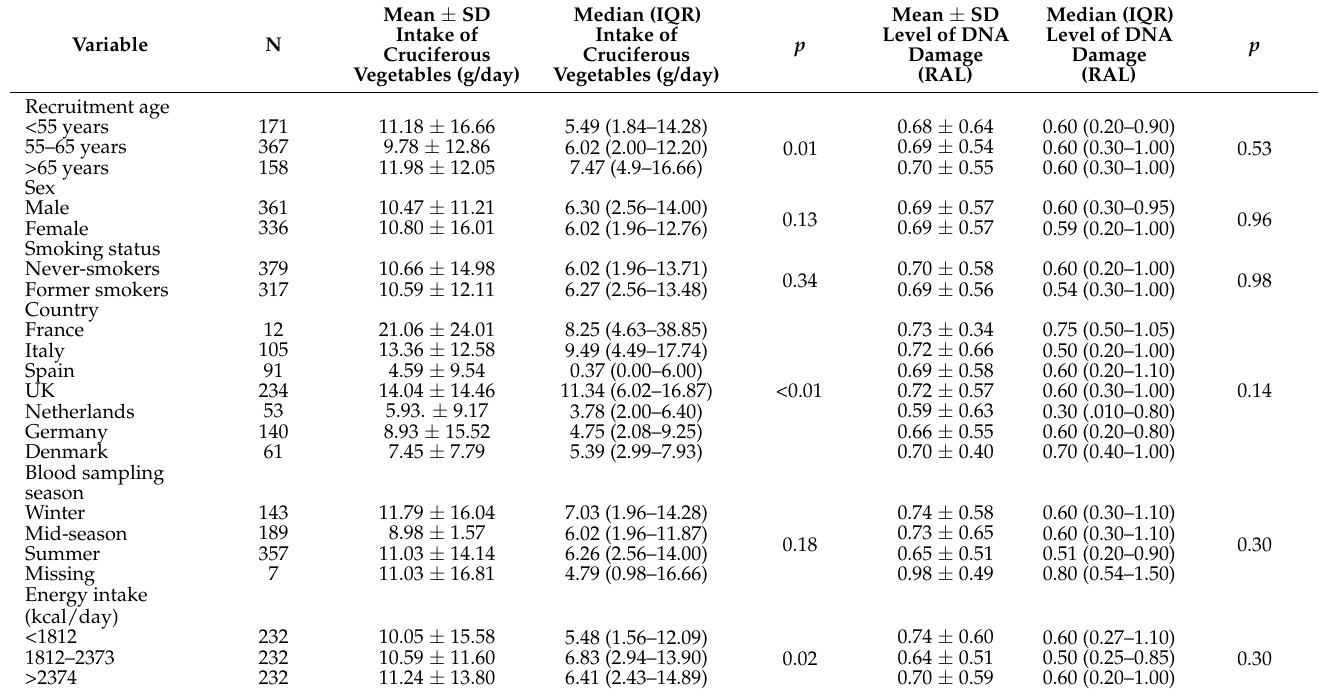
Table 2. Mean daily intake of cruciferous vegetables and mean level of DNA damage by subject demographic